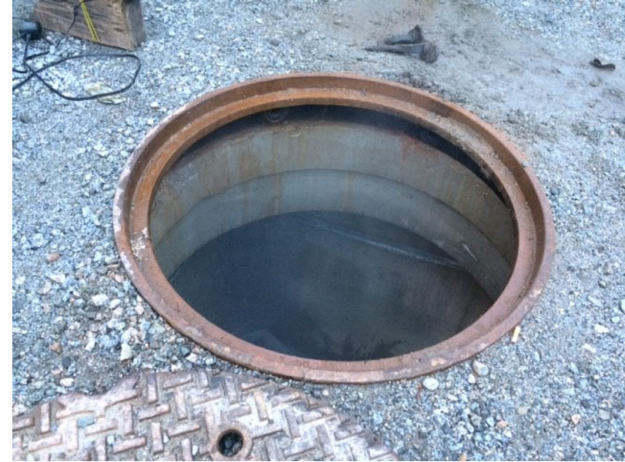
Figure 7. Photo showing emission of “smoke” from the isolated subsurface structure soon after removing the manhole cover. The “smoke” appears as a hazy white coloration of the internal atmosphere.